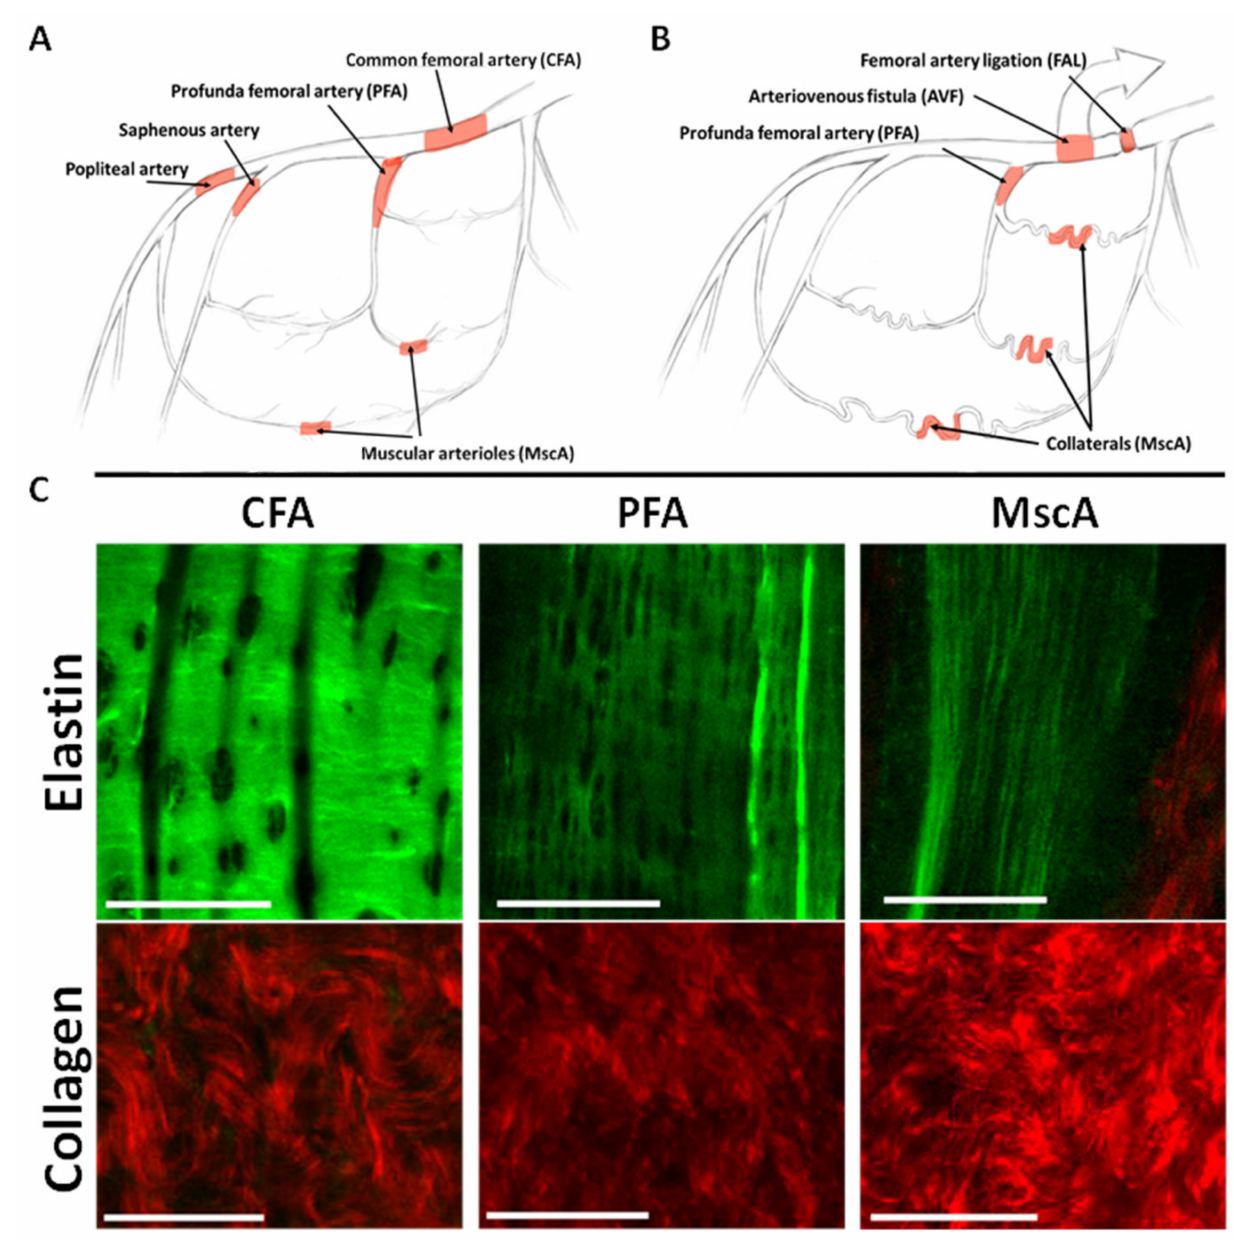
Figure 1. Baseline extracellular matrix structure in various arteries. Shown is a simplified schematic illustration of the lower limb arterial tree in rodents ( A ) and after placement of FAL + AVF in our model ( B ). ( C ) Representative multiphoton microscopy images taken from the intima and adventitia demonstrate the IEL elastin (false colored green) and adventitial collagen (false colored red) of baseline arterial structures. Bar = 50 µ m. N = 3 vessels imaged per group. Images acquired with Olympus FV1000MPE utilizing 830 nm